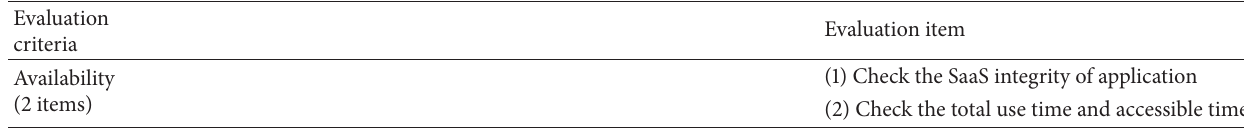
Table 9: Evaluation items of availability of SaaS.